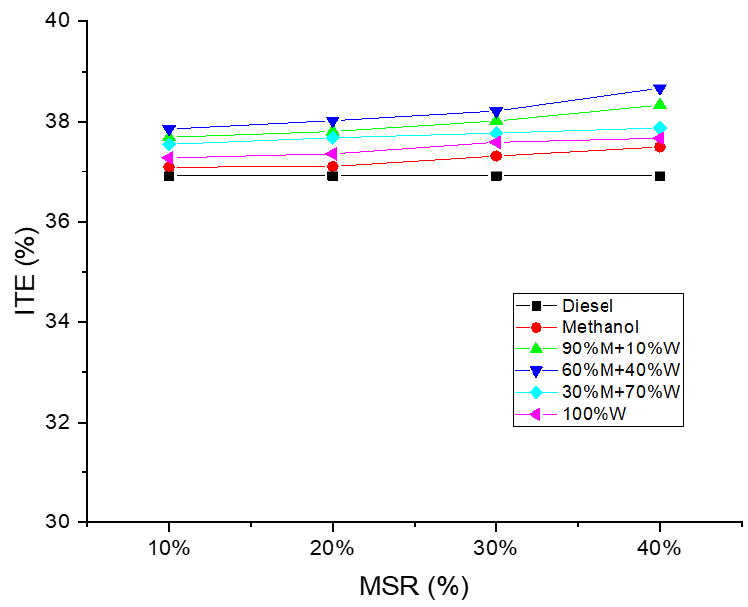
Figure 5. The change of indicated thermal efficiency (ITE) with different fuel mixture ratios.